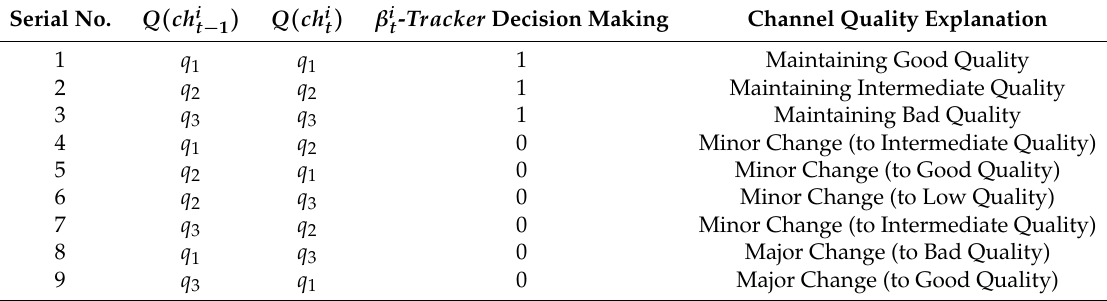
Table 5. β - tracker -based channel decision